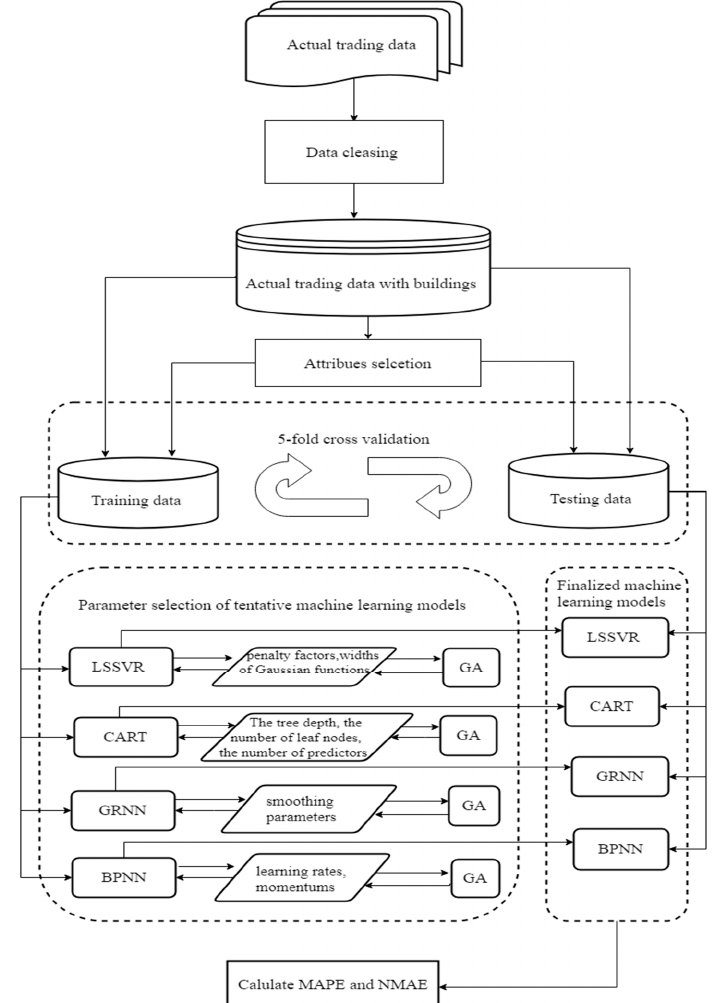
Figure 1. The proposed real estate appraising framework for real estate appraisal.